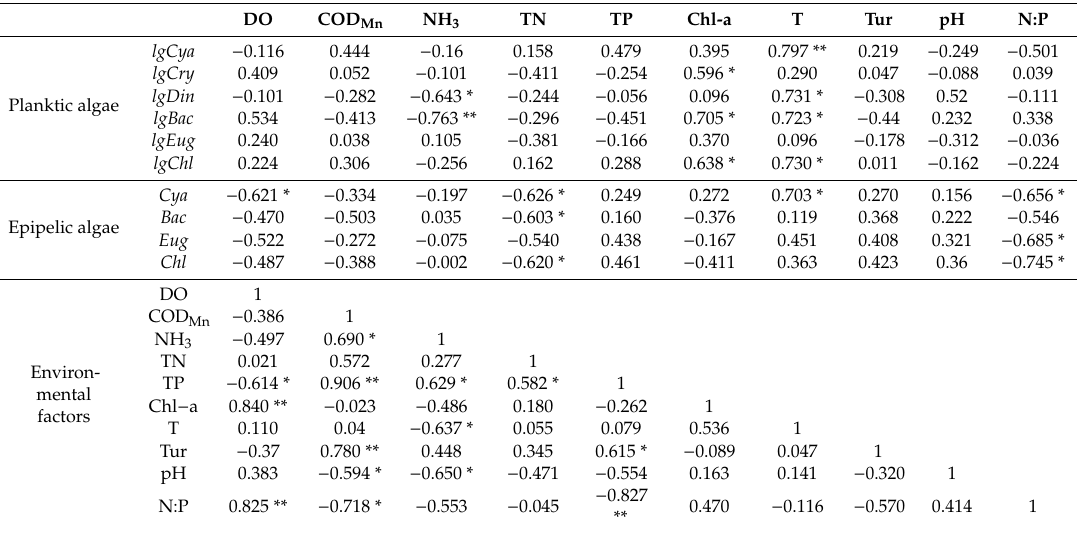
Table 4. Correlation coe ffi cients between algae and environmental factors ( n = 9) from multivariate stepwise regression analysis (MSRA).